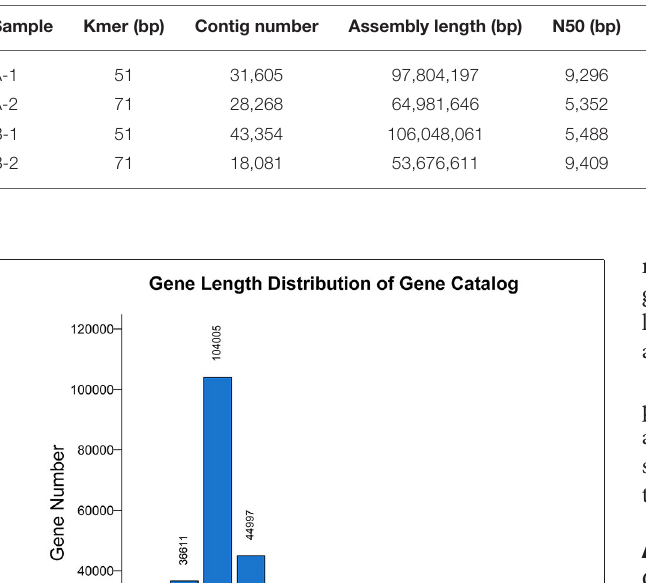
TABLE 2 | Statistics of the assembly results.